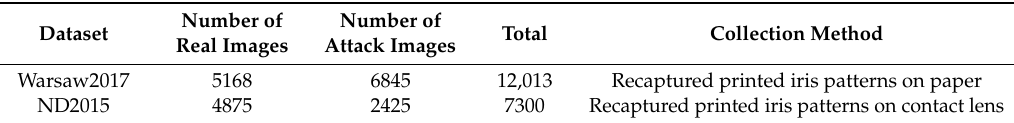
Table 4. Description of Warsaw2017 and ND2015